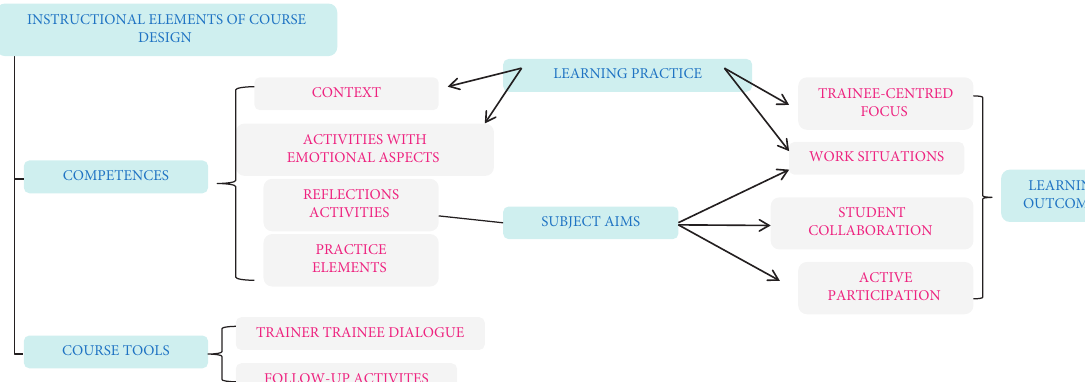
Figure 4: Specification of the design conditions and the instructional elements in the course